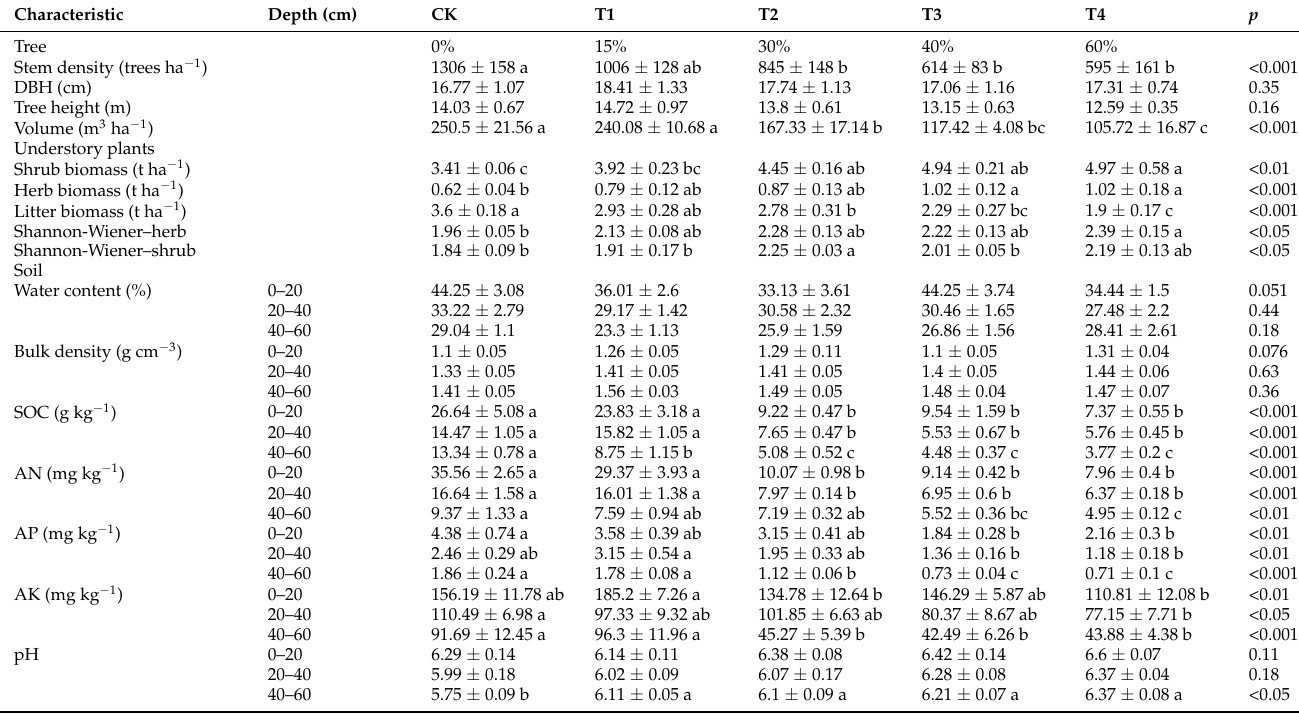
Table 2. Characteristics of the stand and soil (mean ± SE; n =